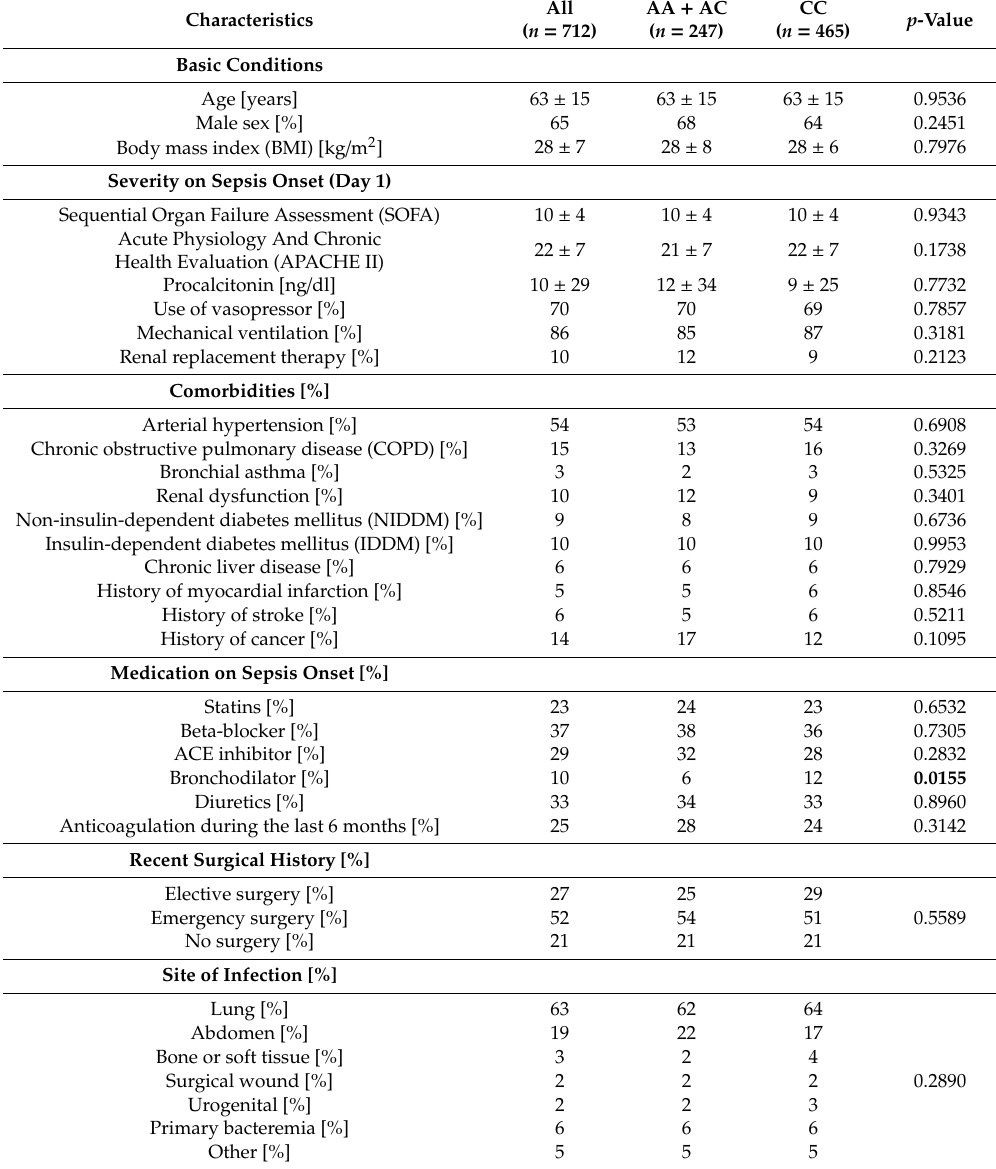
Table 2. Patient baseline characteristics with regard to the TIM-3 rs10515746